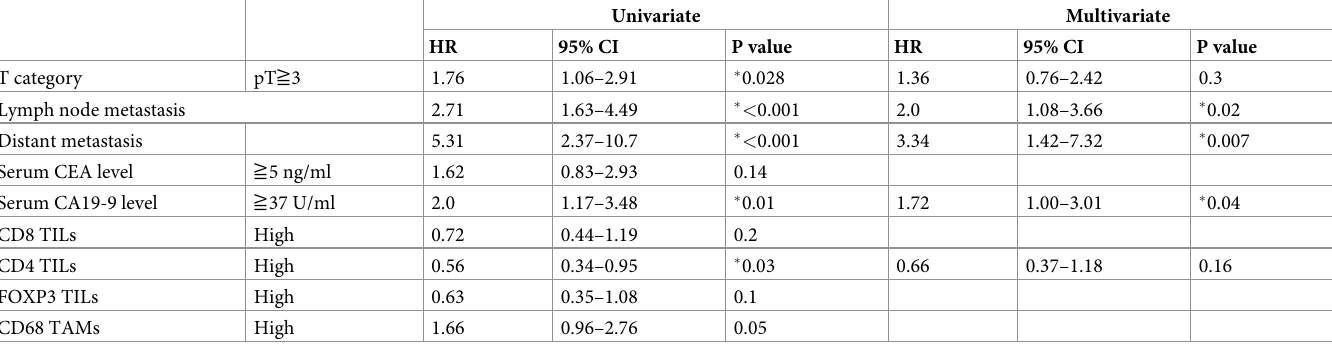
Table 4. Univariate and multivariate cox regression analysis for overall survival in 130 patients with BTC.